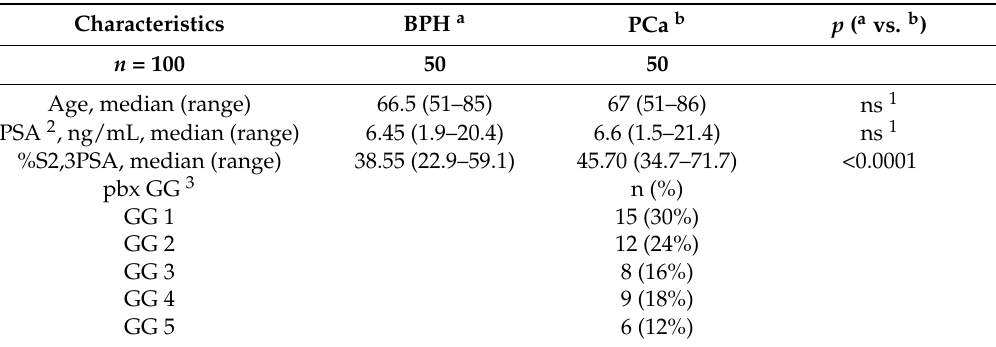
Table 2. Age and total PSA BPH and PCa patients in the validation